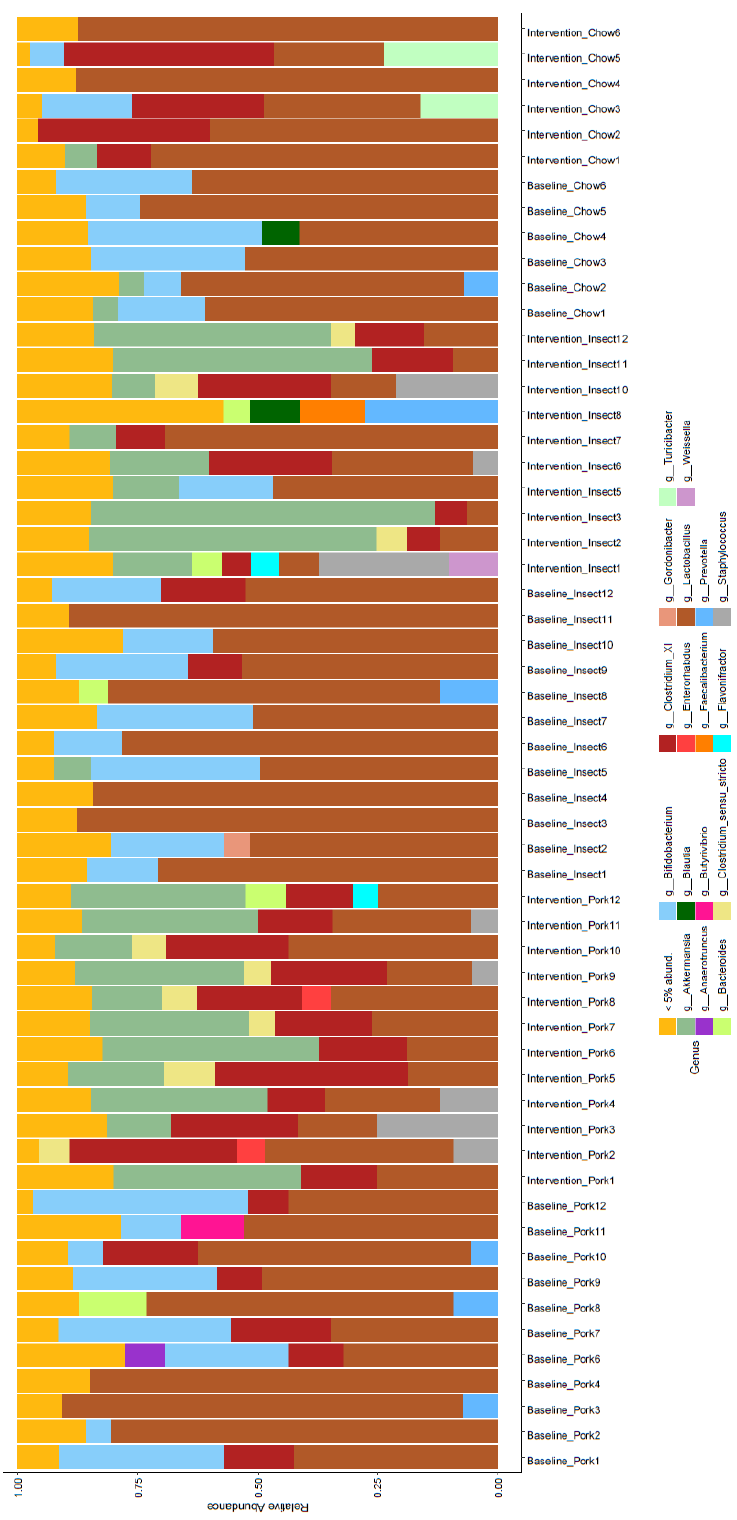
Figure 3. Gut microbiota composition at genus level for the individual rats before and after intervention diet. The gut microbiota composition were analyzed by 16S rRNA sequencing. Gut microbiota composition are shown for the individual rat at baseline and after intervention with chow diet (Chow), pork sausage diet (Pork) or insect-substituted pork diet shown as the relative abundance at genus level.